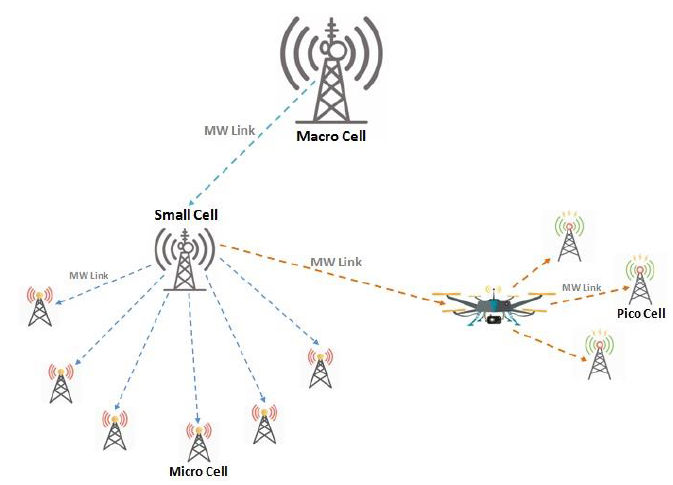
Fig 10. UAV assisted coverage extension